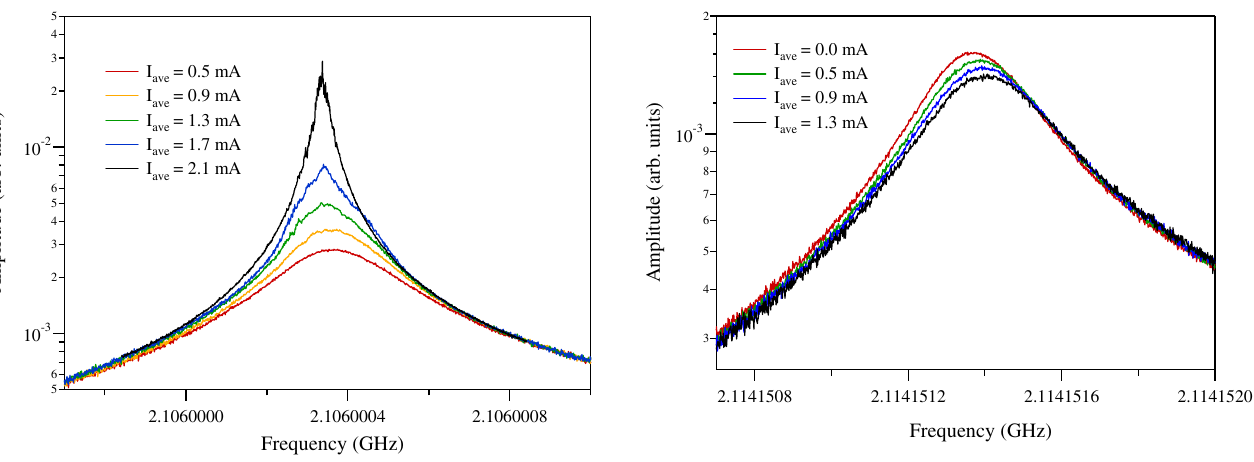
FIG. 6. (Color) The resonance curve for the 2114 MHz HOM as a function of average beam current with nominal, decoupled optics. Note that the effective Q of the curve decreases as the current increases. This indicates the system is stable.